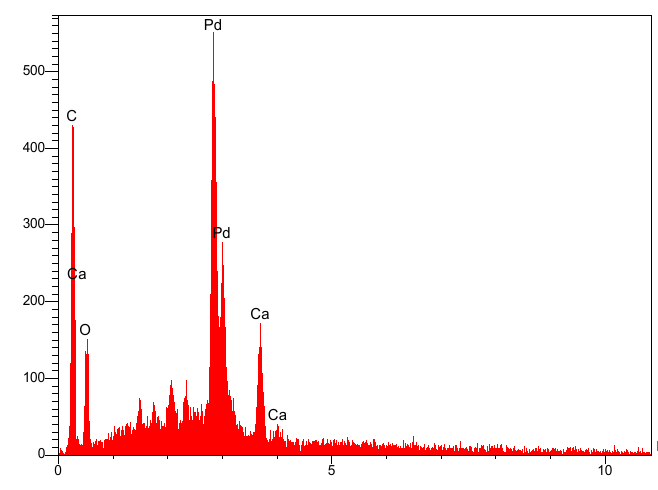
Figure 11. EDS spectrum of recycled Pd/coral reef nanocomposite.